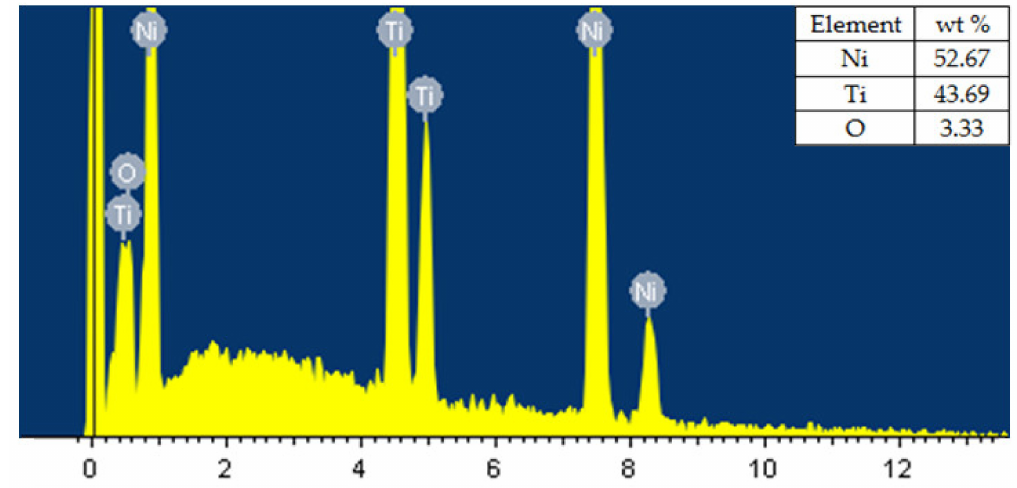
Figure 9. Elemental composition of nitinol shape-memory alloy(SMA) using